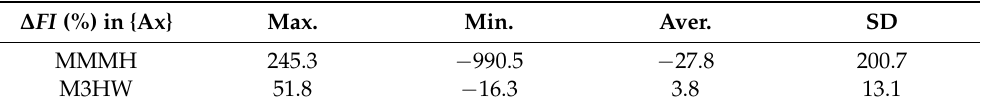
Table 13. Comparison of the MMMH and M3HW versions of the MMMH criterion on the {Ax} group from the FatLim data set. ∆ FI (%) in {Ax} Max. Min. Aver. SD MMMH 245.3 − 990.5 − 27.8 200.7 M3HW 51.8 − 16.3 3.8